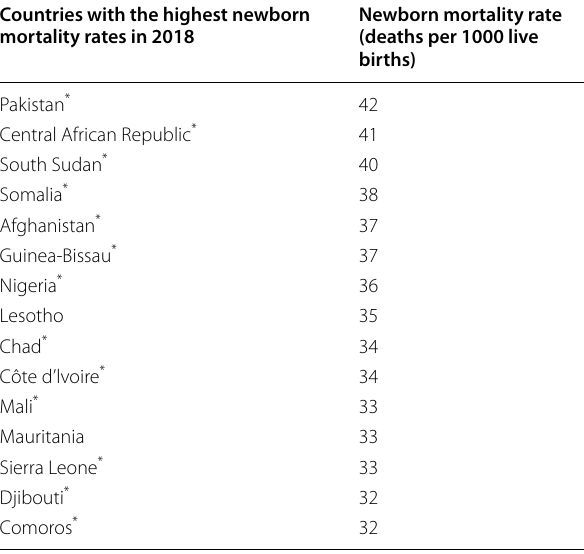
Table 1 Top 15 countries in 2018 with the highest neonatal mortality rates. Countries listed with an asterisk have been identified as a ‘fragile and conflict situation’ by the World Bank Group in the 2018 financial